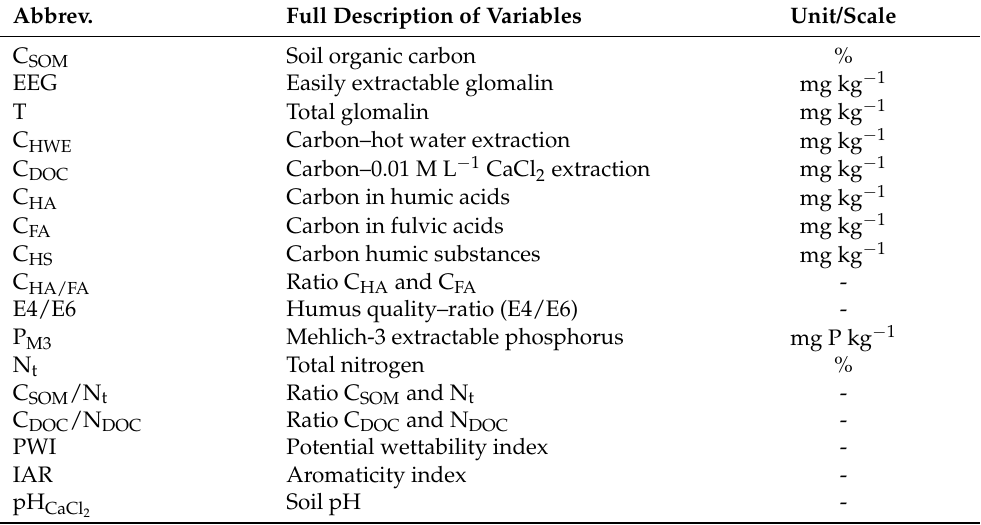
Table 4. Description of